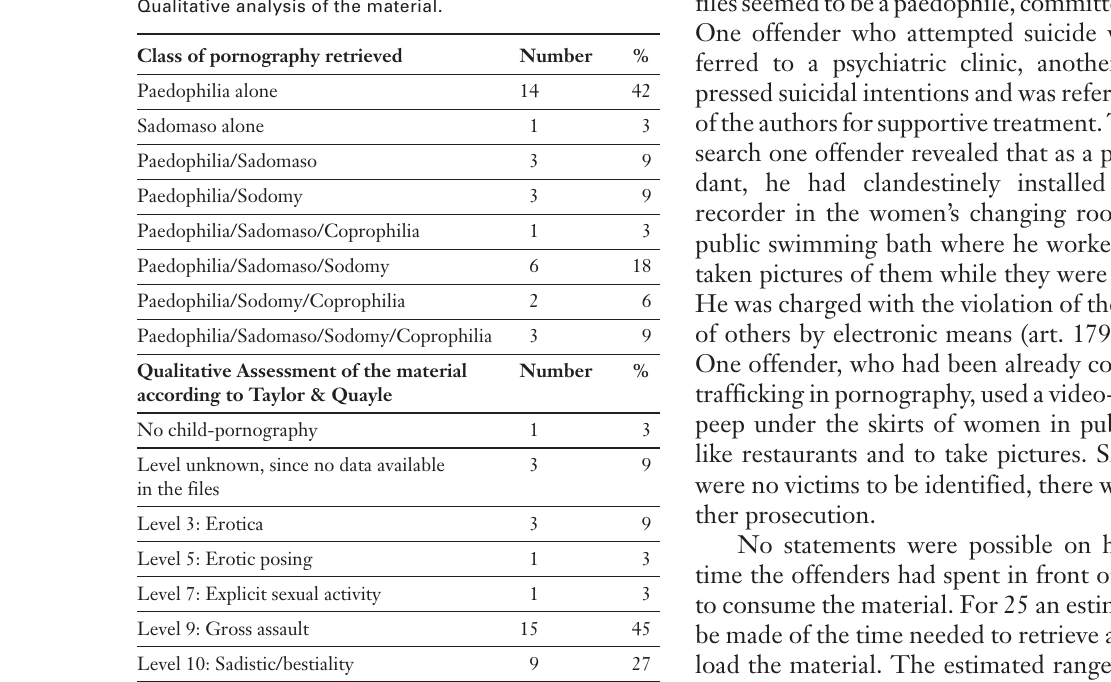
Qualitative analysis of the